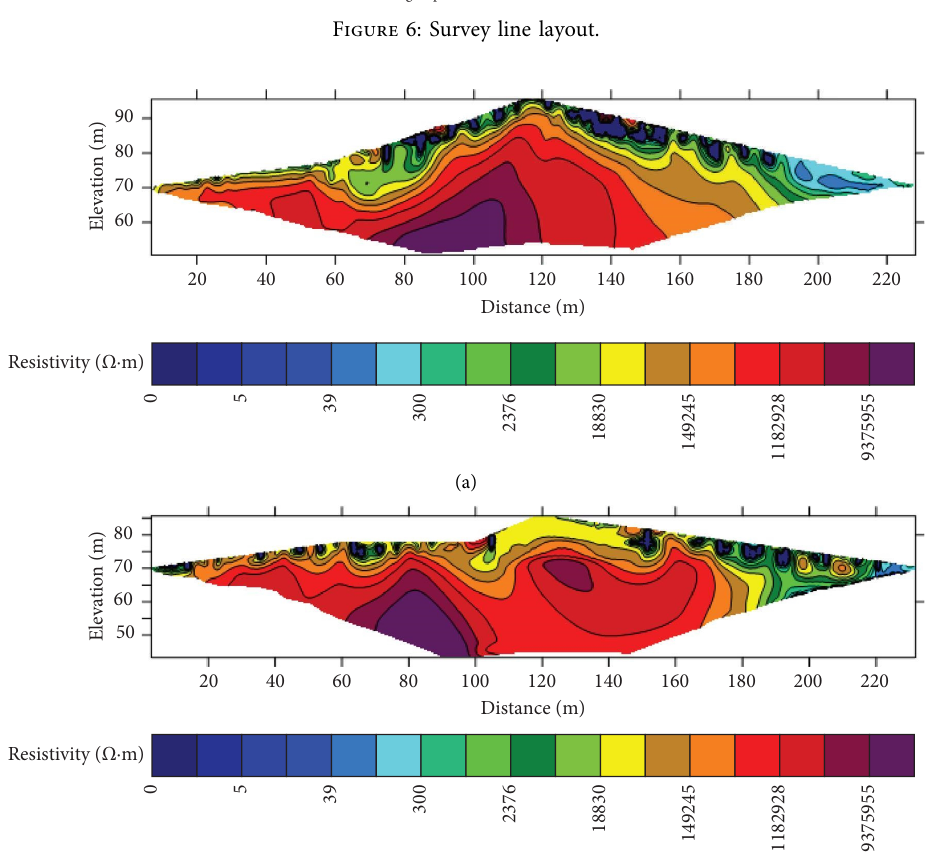
Figure 7: Resistivity profle. (a) Line 1. (b) Line